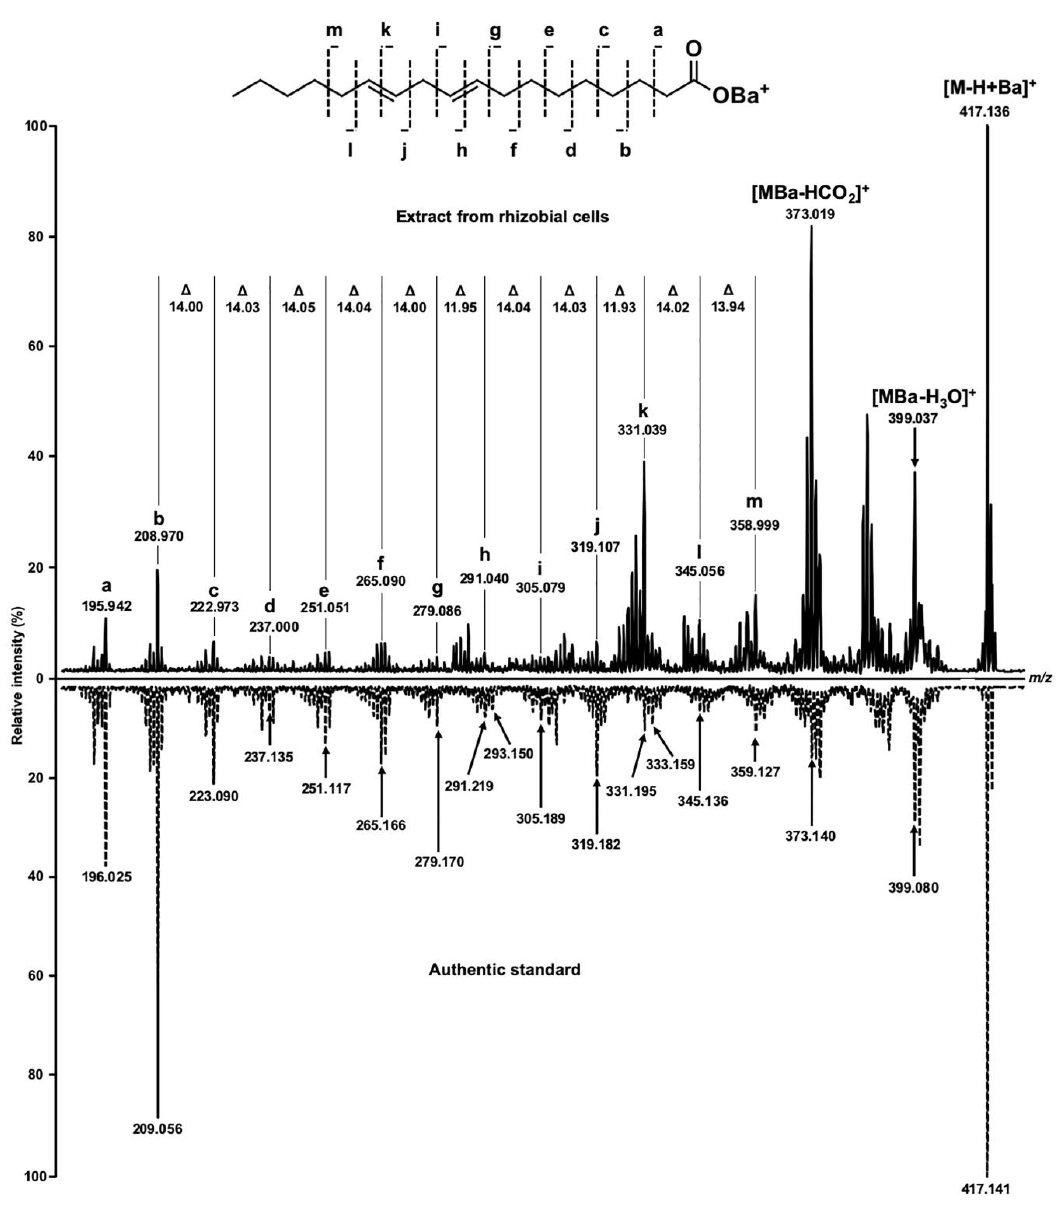
Figure 4. MS/MS spectra of m/z 417.14, corresponding to [M-H+Ba] + ion of linoleic acid. The authentic standard of linoleic acid was dissolved in n -hexane and applied on MALDI target in the same way as the extract from rhizobial cells. The double bonds were localized by characteristic methine mass shifts (12 m/z ), which could be annotated to the fragments h and k.